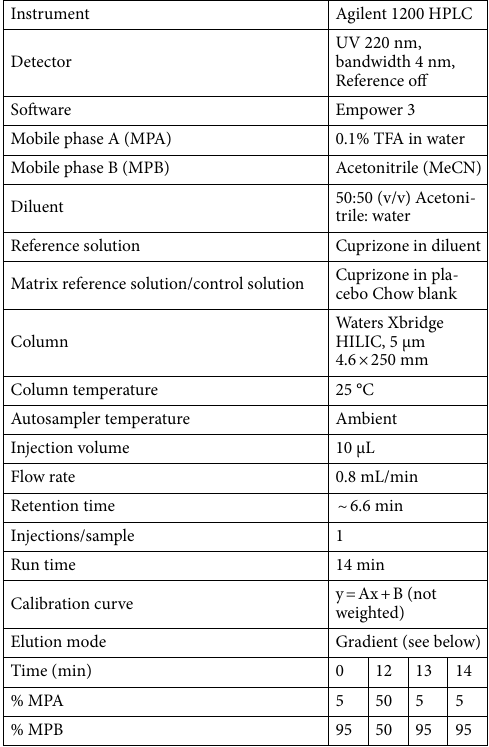
Table 1. Analytical